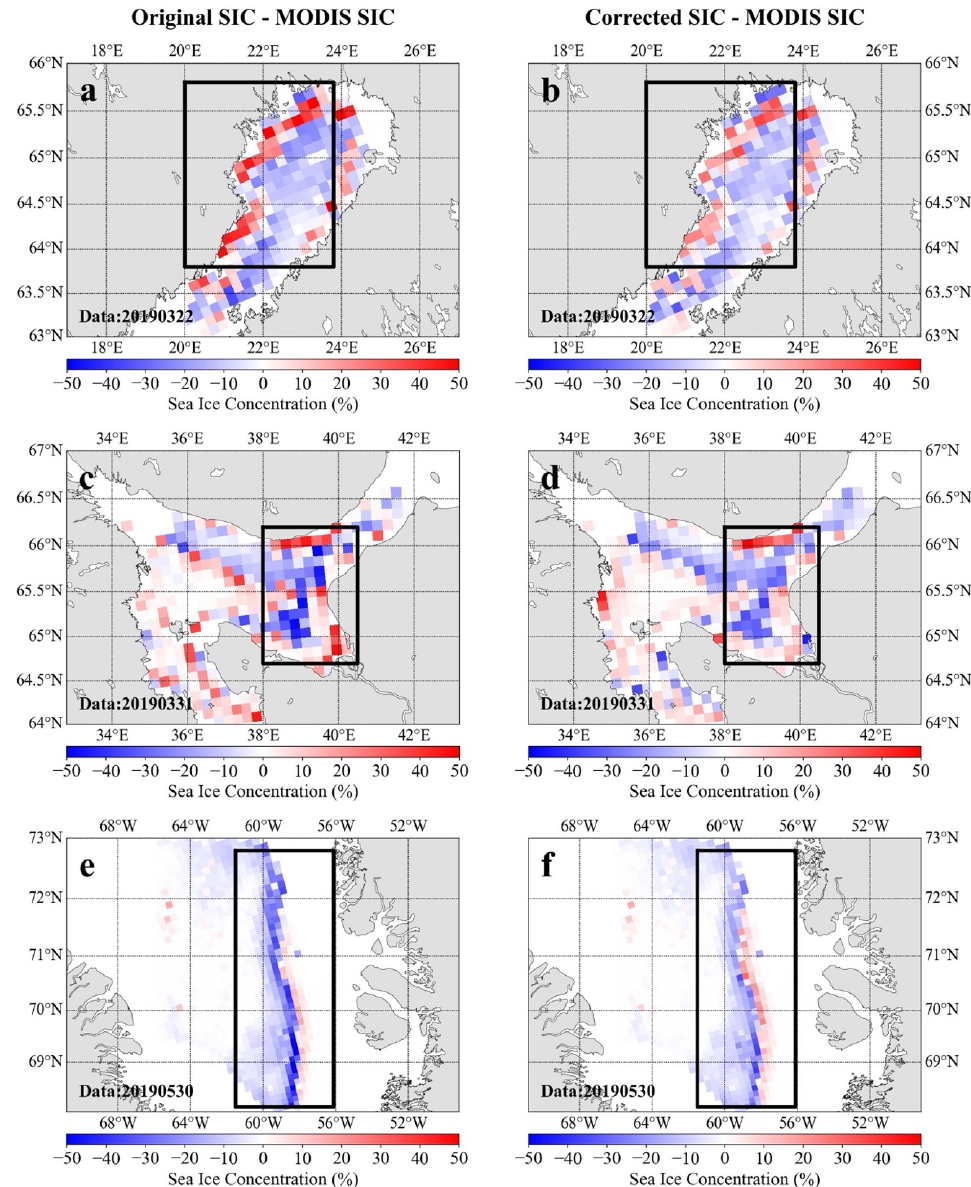
Figure 10. The spatial differences between the SICs from the MWRI images and the MOD09 images in three sample regions. These sample regions are shown as the black boxes labeled by numbers in Figure 9. From top to bottom, the regions are Gulf of Bothnia ( a , b ), White Sea ( c , d ), and Davis Strait ( e , f ). Table 4. Comparisons of the SICs from the uncorrected and corrected images. MAE and R are mean absolute error and correlation coefficient, respectively.